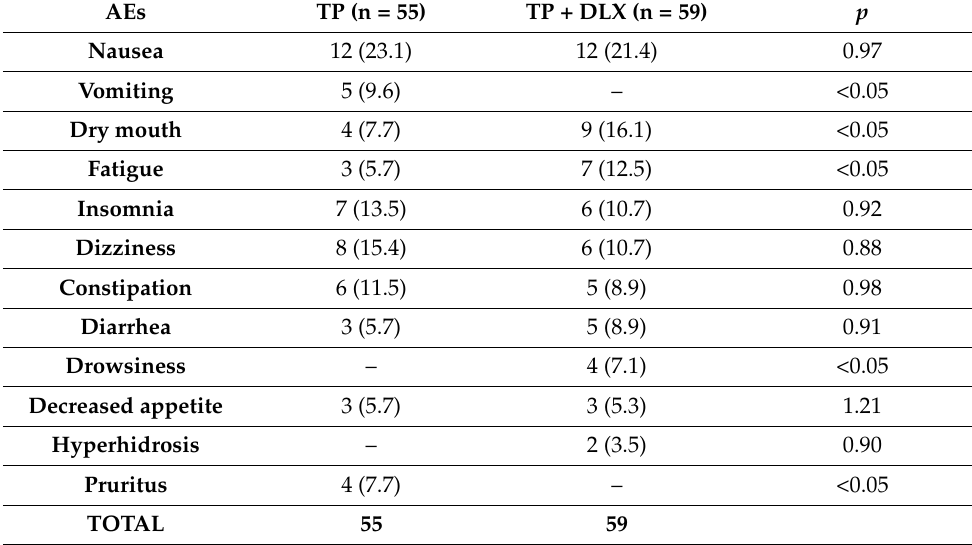
Table 3. Adverse Events (AEs) during treatment with tapentadol and